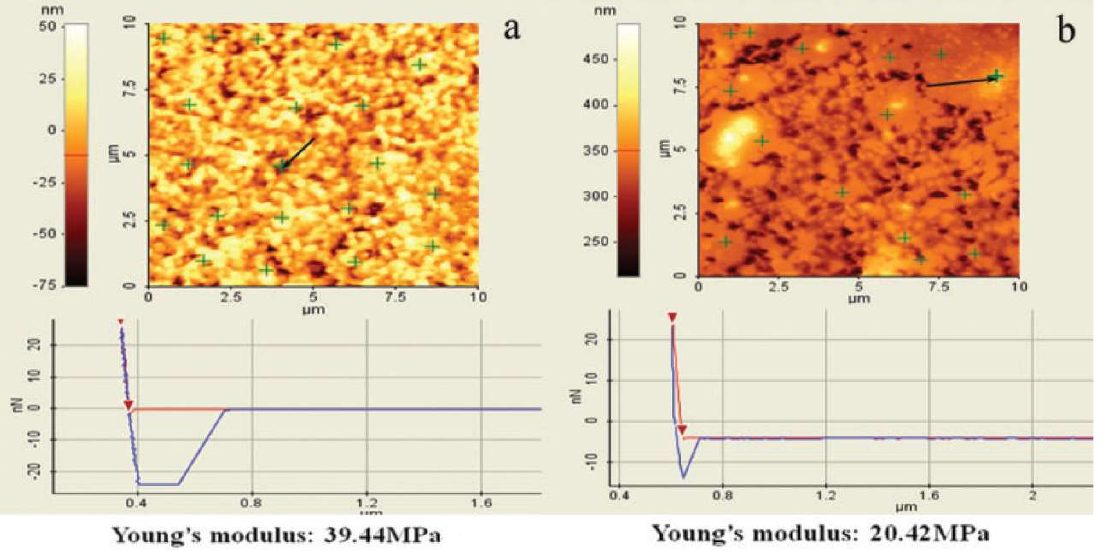
Figure 21. Young’s modulus calculation results of EPDM: ( a ) pure cured EPDM, and; ( b ) EPDM in EPDM/ENR50 (75/25) blend